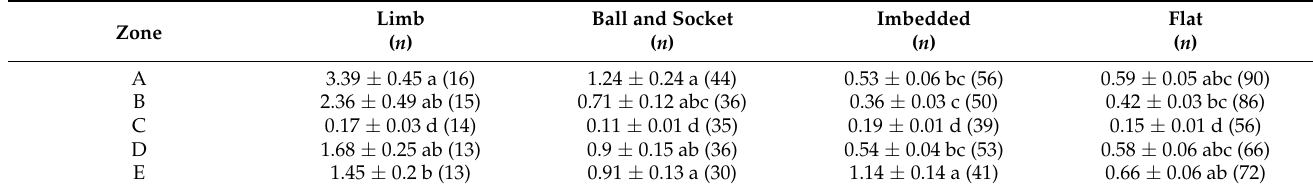
Table 3. Mean max strain ± SE and ( n ) for each branch union zone separated by failure mode. Mean with different letters in the column using Tukey HSD were found to be different. Data were analyzed using Log 10 but untransformed (original scale) means and SE are used for presentation purposes.